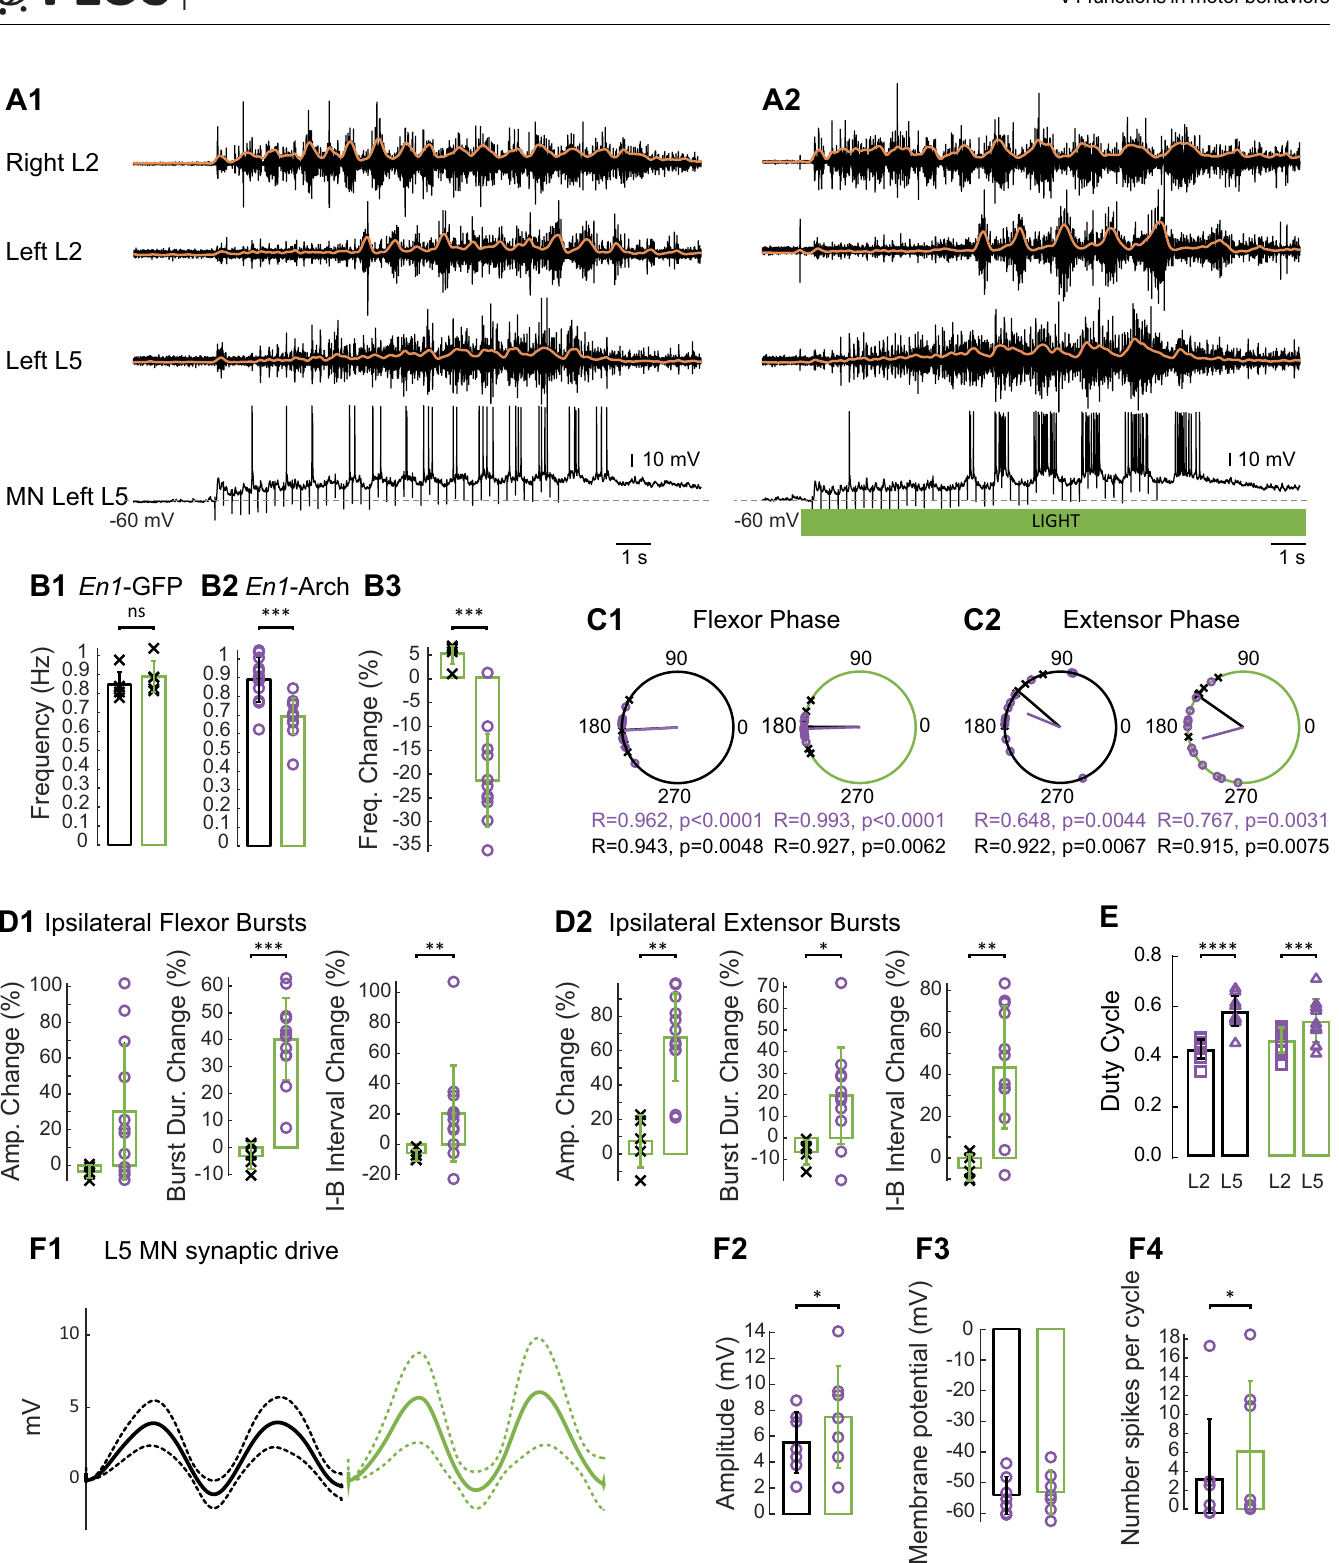
Fig 3. Hyperpolarization of V1 interneurons slows dorsal root–evoked fictive locomotion and enhances rhythmic drive. (A) Fictive locomotion evoked by sacral dorsal root stimulation before (A1) and during (A2) hyperpolarization of En1 -positive neurons in an En1 -Arch spinal cord. The black traces show the high-pass (10 Hz) filtered signal from the right and left L2 and the left L5 ventral roots together with an intracellular recording from an extensor MN in the left L5 segment.